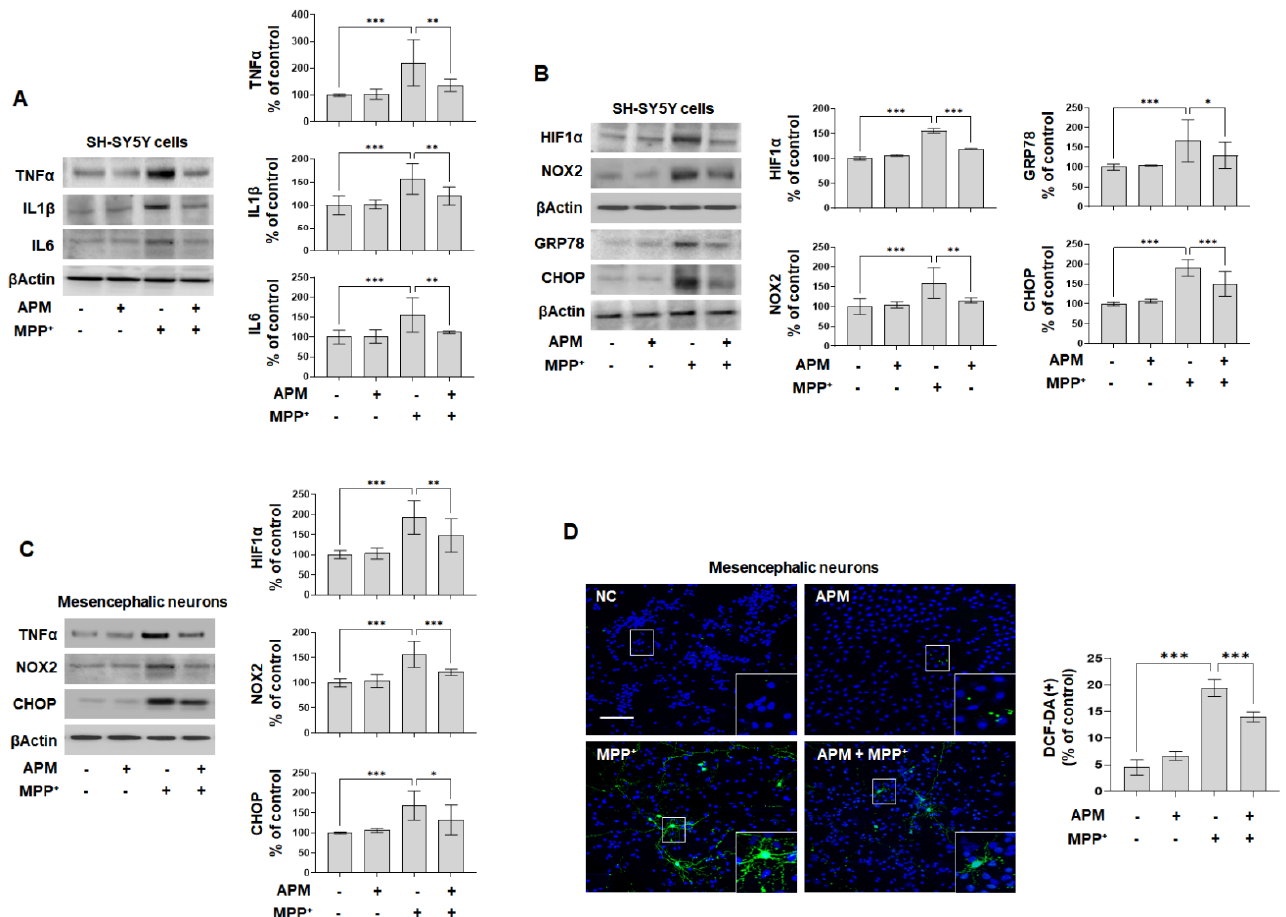
Figure 4. APM alleviated MPP + -induced neuroinflammatory response, oxidative stress, and ER stress. Dopaminergic neuronal cells were incubated in the presence or absence of APM for 1 h and then treated with MPP + for 24 h. Expression of inflammatory cytokines ( A ), HIF1 α, NOX2, GRP78 , and CHOP ( B ) in SH-SY5Y cells were analyzed by immunoblotting. ( C ) Expression of TNFα, NOX2 , and CHOP in rat embryo primary mesencephalic neurons were confirmed by immunoblotting. β Actin was used to confirm equal sample loading. ( D ) ROS generation in rat embryo primary mesencephalic neurons was detected by DCF-DA staining (green, scale bars: 100 μm ). Nuclei were stained with DAPI (blue). Immunoblotting and immunofluorescence positive cells were quantified by densitometric analysis. The data are representative of three independent experiments and quantified as mean values ± SEM. Tukey’s multiple comparison test, * p < 0.05, ** p < 0.01, *** p < 0.001 compared to normal control.